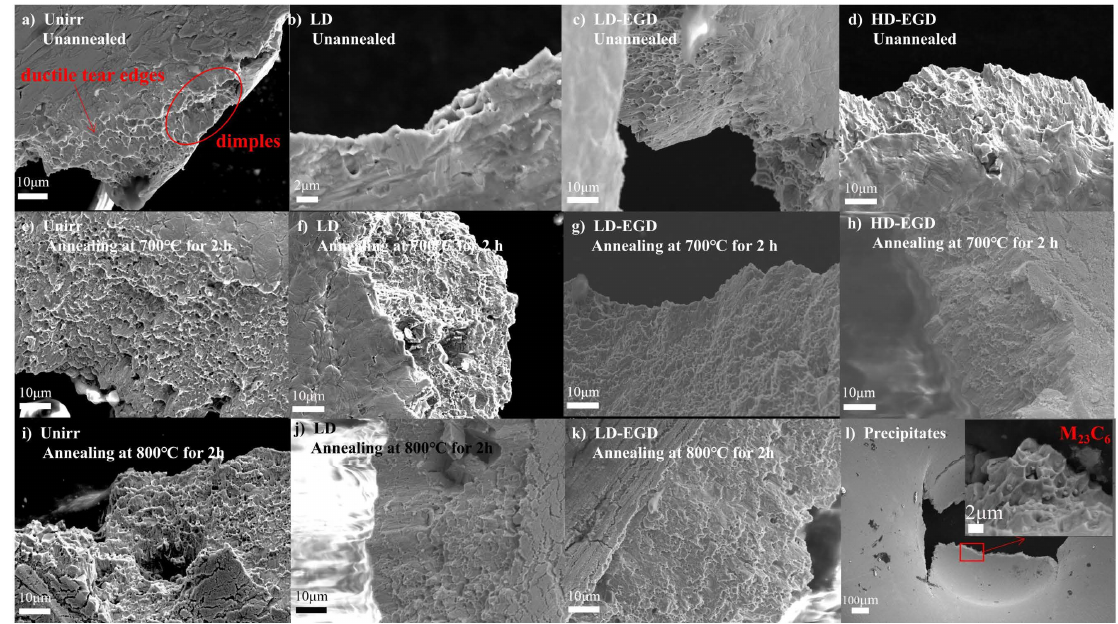
Figure 5. Section morphology of samples under different annealing conditions: ( a ) unirradiated and unannealed sample, ( b ) unannealed LD sample, ( c ) unannealed LD-EGD sample, ( d ) unannealed HD-EGD sample. ( e ) Unirradiated and annealed at 700 ◦ C for 2 h, ( f ) LD and annealed at 700 ◦ C for 2 h, ( g ) LD-EGD and annealed at 700 ◦ C for 2 h, ( h ) HD-EGD and annealed at 700 ◦ C for 2 h. ( i ) Unirradiated and annealed at 800 ◦ C for 2 h, ( j ) LD and annealed at 800 ◦ C for 2 h, ( k ) LD-EGD and annealed at 800 ◦ C for 2 h, ( l ) precipitates at the fracture